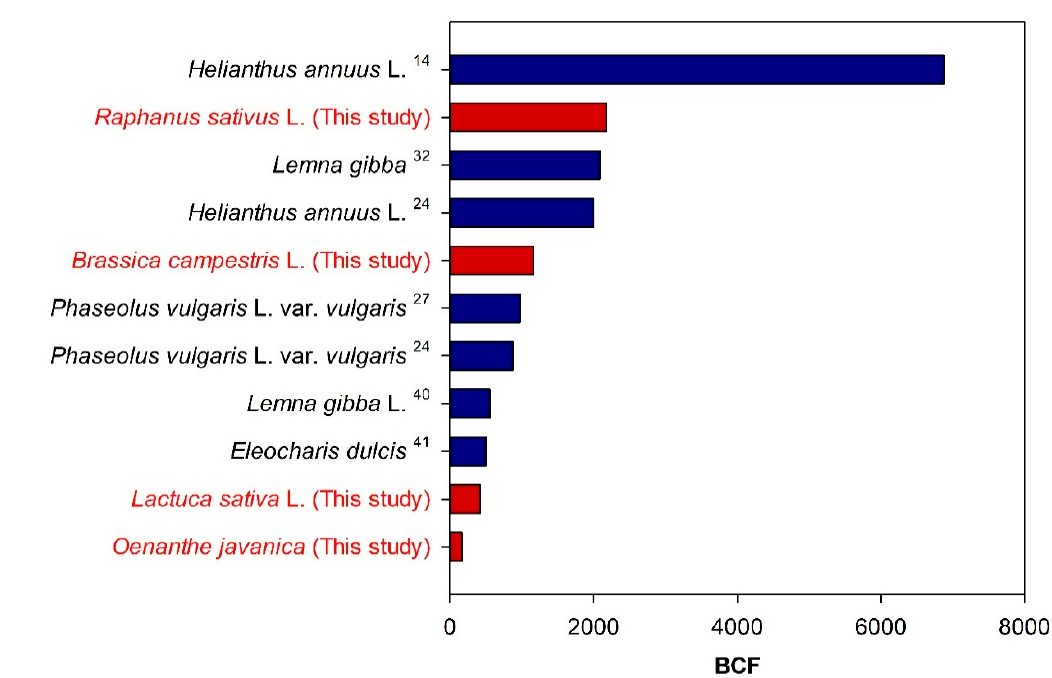
Figure 8. Average uranium BCFs of various plants after accumulation experiments using genuine groundwater and surface water. The BCF values were obtained from previous studies.